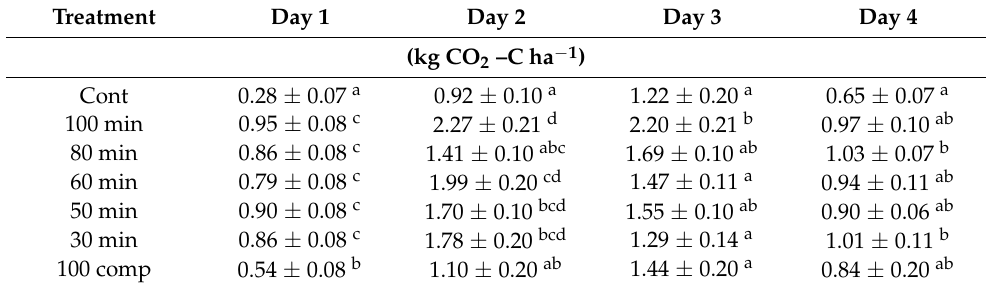
Table A4. Daily emission of carbon dioxide (CO 2 ) at 75% water-filled pore space in different fertilizer treatments (incubation experiment). Only the days with significant differences between the treatments are